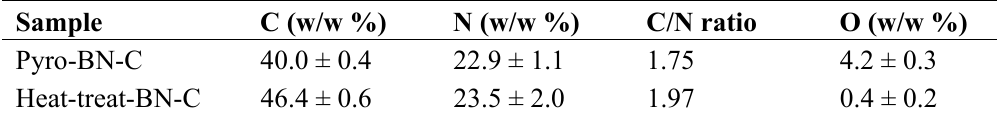
Table 1. Chemical composition of the as-pyrolysed (Pyro-BN-C at 1,050 °C, 2 h, N and the heat-treated (Heat-treat-BN-C at 1,850 °C, 2 h, N elemental